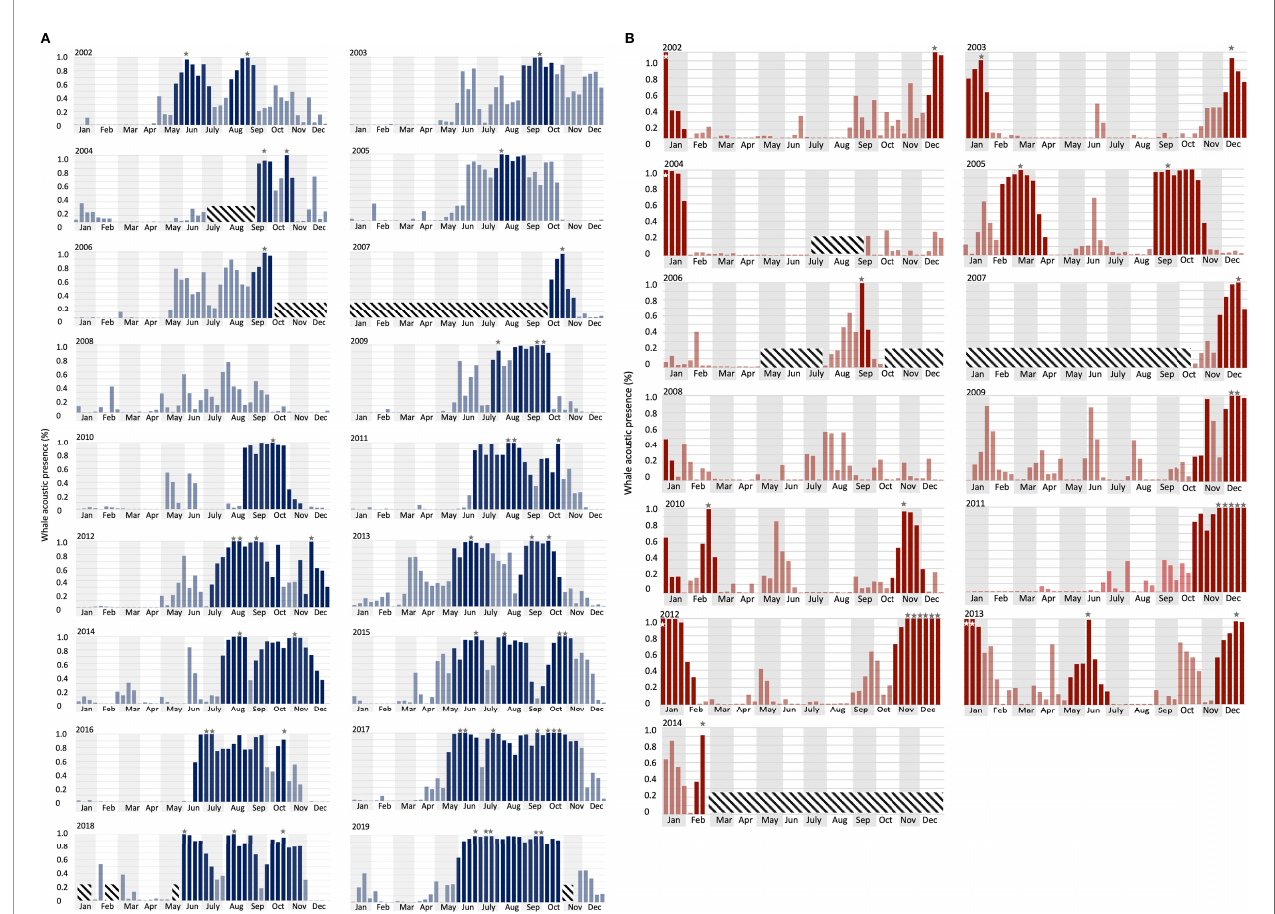
FIGURE 5 | Long-term whale acoustic presence (de fi ned as the percentage of hours when whale songs were detected, see Material and Methods ) at (A) DGS (from 2002 to 2019) and (B) DGN (from 2002 to 2014). Vertical bars indicate the proportion of hours that one or more Chagos whale songs were detected in each eight-day period. Grey/white stars indicate peak time when there were more than 90% of the hours with Chagos song detections. Darker bars are the extended peak seasons that contain (as de fi ned in the Methods section). Diagonal crosshatch- fi lled shades were unavailable data (See Material and Methods for the de fi nition of the extended peak